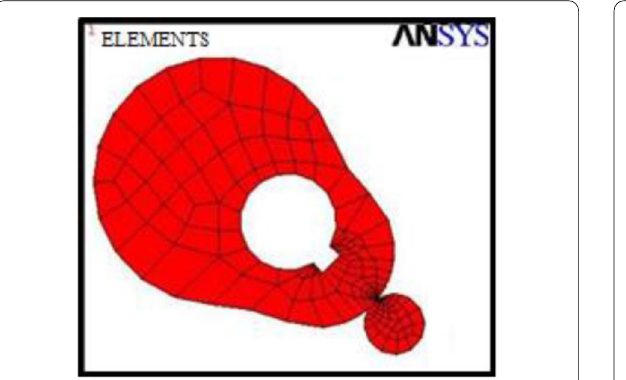
Figure 7 Mesh generation when the follower located at 180° with the cam